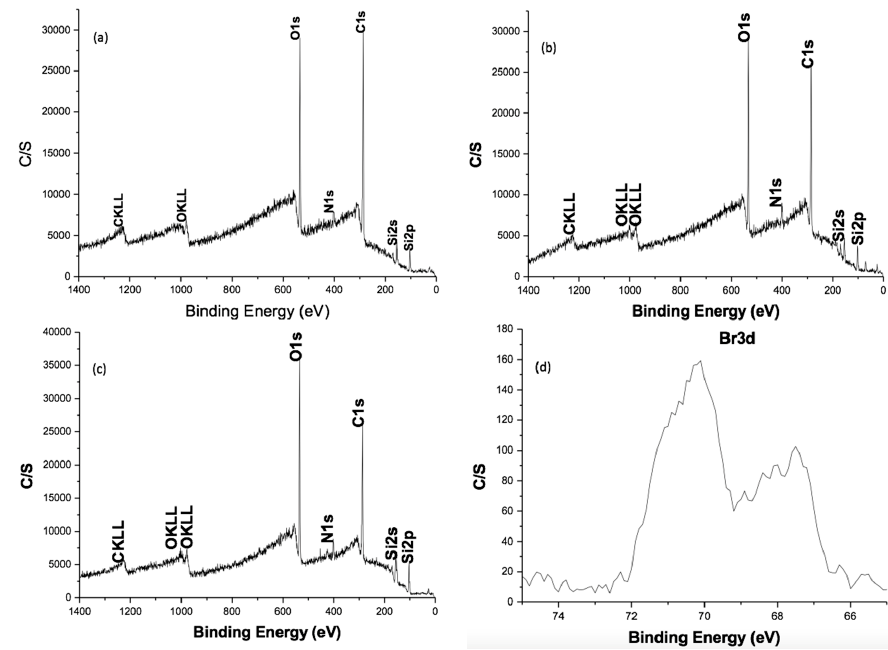
Figure 2. Wide scan photoelectron spectrum of the ( a ) CS, ( b ) CS-BIB initiator ( c ) CS- g -PA and ( d ) high resolution spectrum of the Br in the CS-BIB initiator.